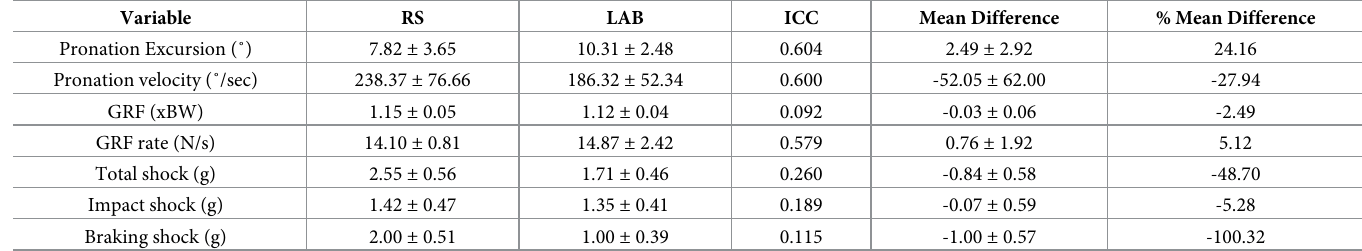
Table 4. Comparison of right foot data from all variables (Mean ± SD), with ICC and mean differences